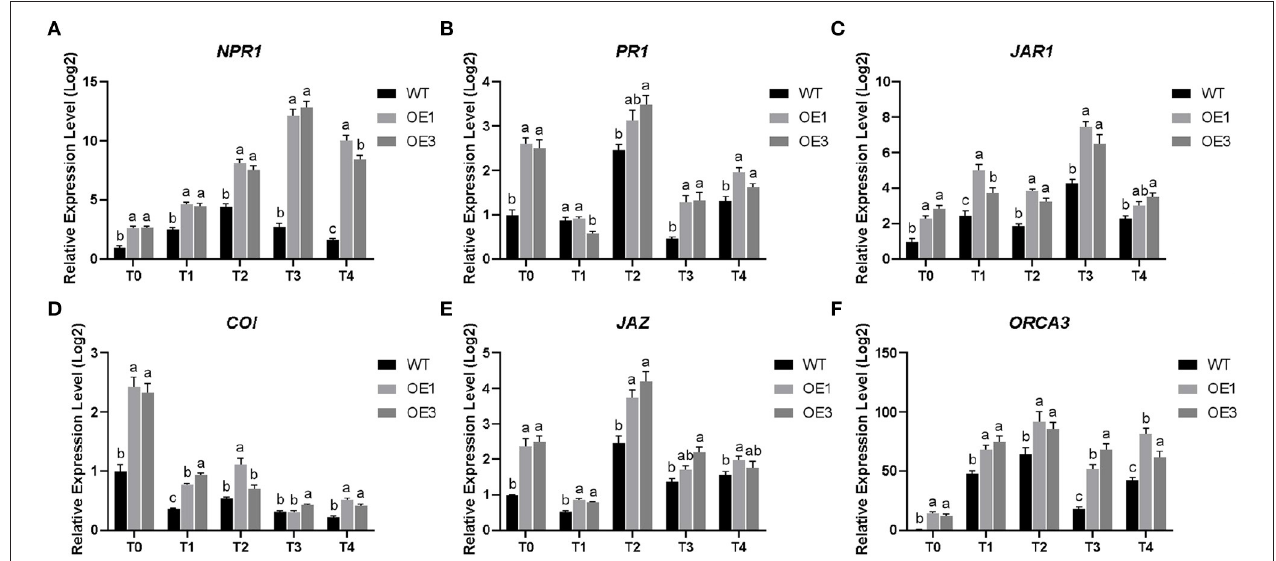
FIGURE 9 | Differential expression level of six defense-associated genes in Populus davidiana × P. alba var. pyramidalis Louche (PdPap) after infection with Fusarium oxysporum . (A) nonexpressor of pathogenesis-related genes ( NPR1 ); (B) pathogenesis-related protein genes ( PR1 ); (C) jasmonic acid resistant gene ( JAR1 ); (D) coronatine insensitive protein gene ( COI ); (E) jasmonate ZIM-domain gene ( JAZ ); (F) Octadecaniod-derivative response AP2 domain ( ORCA3 ). T0–T4: Infection time was 0, 6, 12, 24, and 48h. Error bars represented the standard deviation of the three independent replicates. Significant differences ( P < 0.05) were indicated by different lowercase letters. WT: wildtype Pdpap; OE1, OE3: transformant